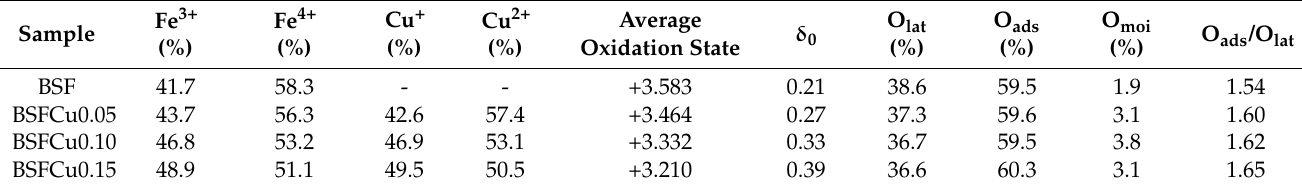
Figure 4. ( a ) Cu 2p 3/2 , ( b ) Fe 2p 3/2 , and ( c ) O 1s XPS spectra of the Ba 0.5 Sr 0.5 Fe 1 − x Cu x O 3 − δ (x = 0, 0.05, 0.10, 0.15). The circles are the experimental data, the red line is the fitting curve. Table 2. Fitting results of the Fe 2p 3/2 , Cu 2p 3/2 , and O 1s XPS spectra of the Ba 0.5 Sr 0.5 Fe 1 − x Cu x O 3 − δ (x = 0, 0.05, 0.10, 0.15).